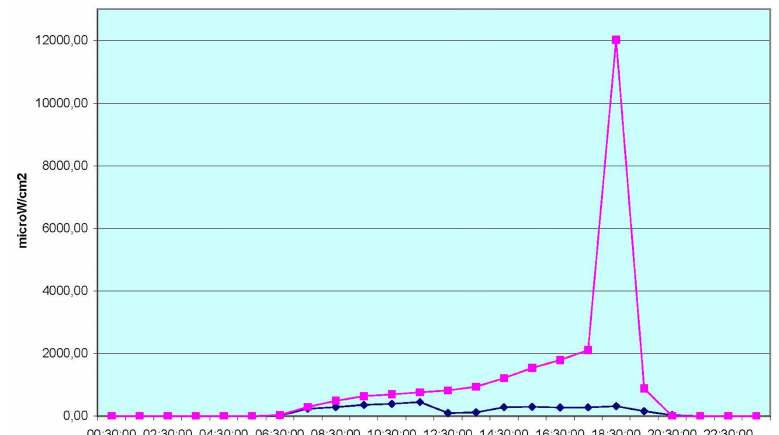
Fig. 6 Incoming global solar radiation, detected in the 2015.07.29 th (Step 3). Magenta LE, Blue